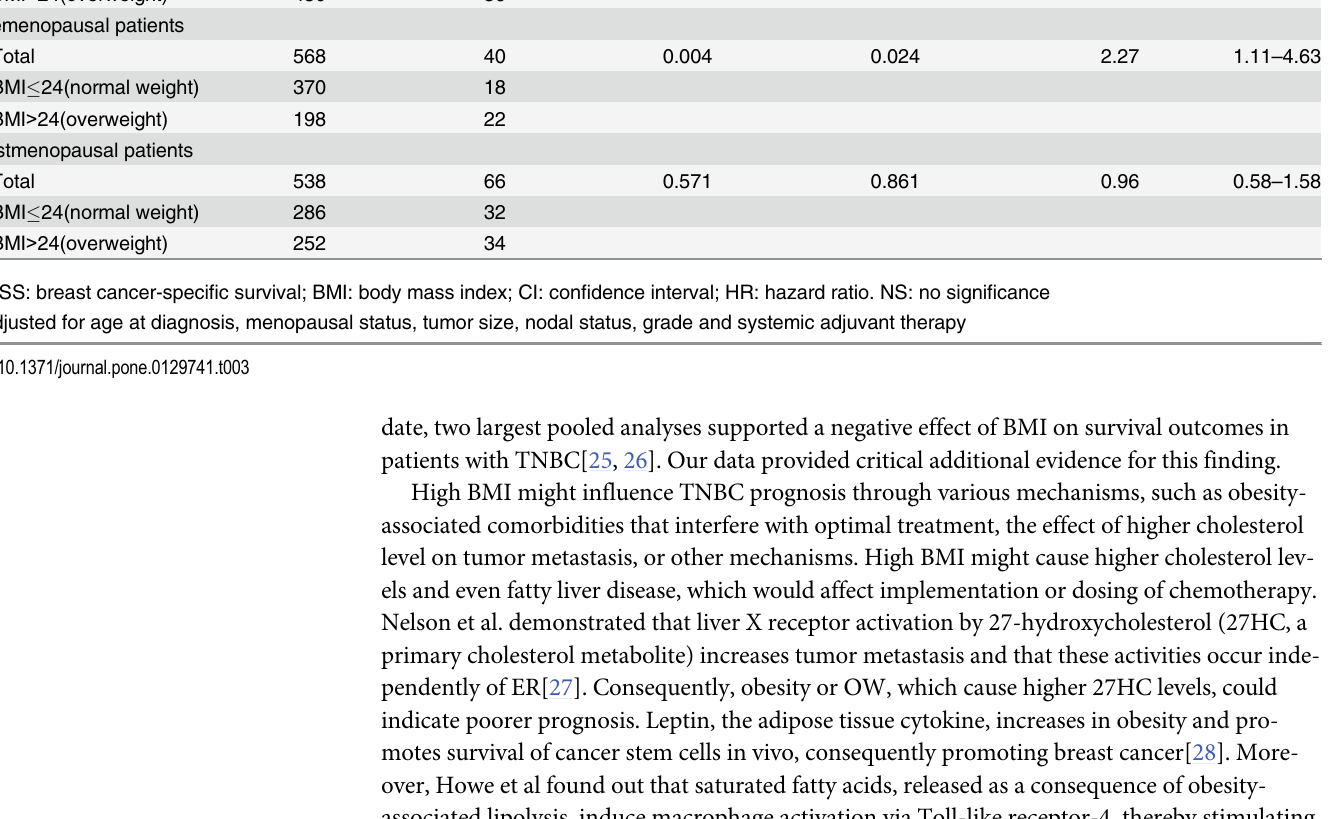
Table 4. Univariate and multivariate OS survival analysis of BMI in TNBC patients according to menopausal status. Menopausal